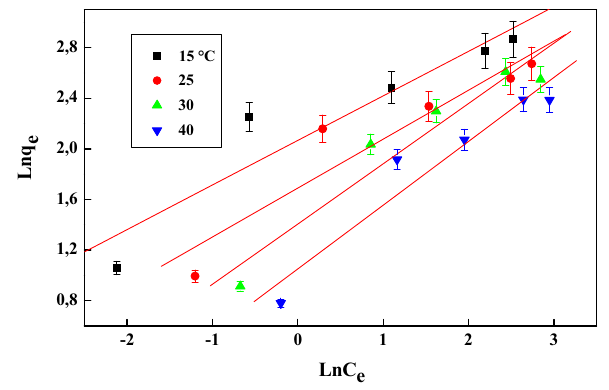
Fig. 7 The Freundlich adsorption isotherm for pre-treated coffee waste at various temperatures